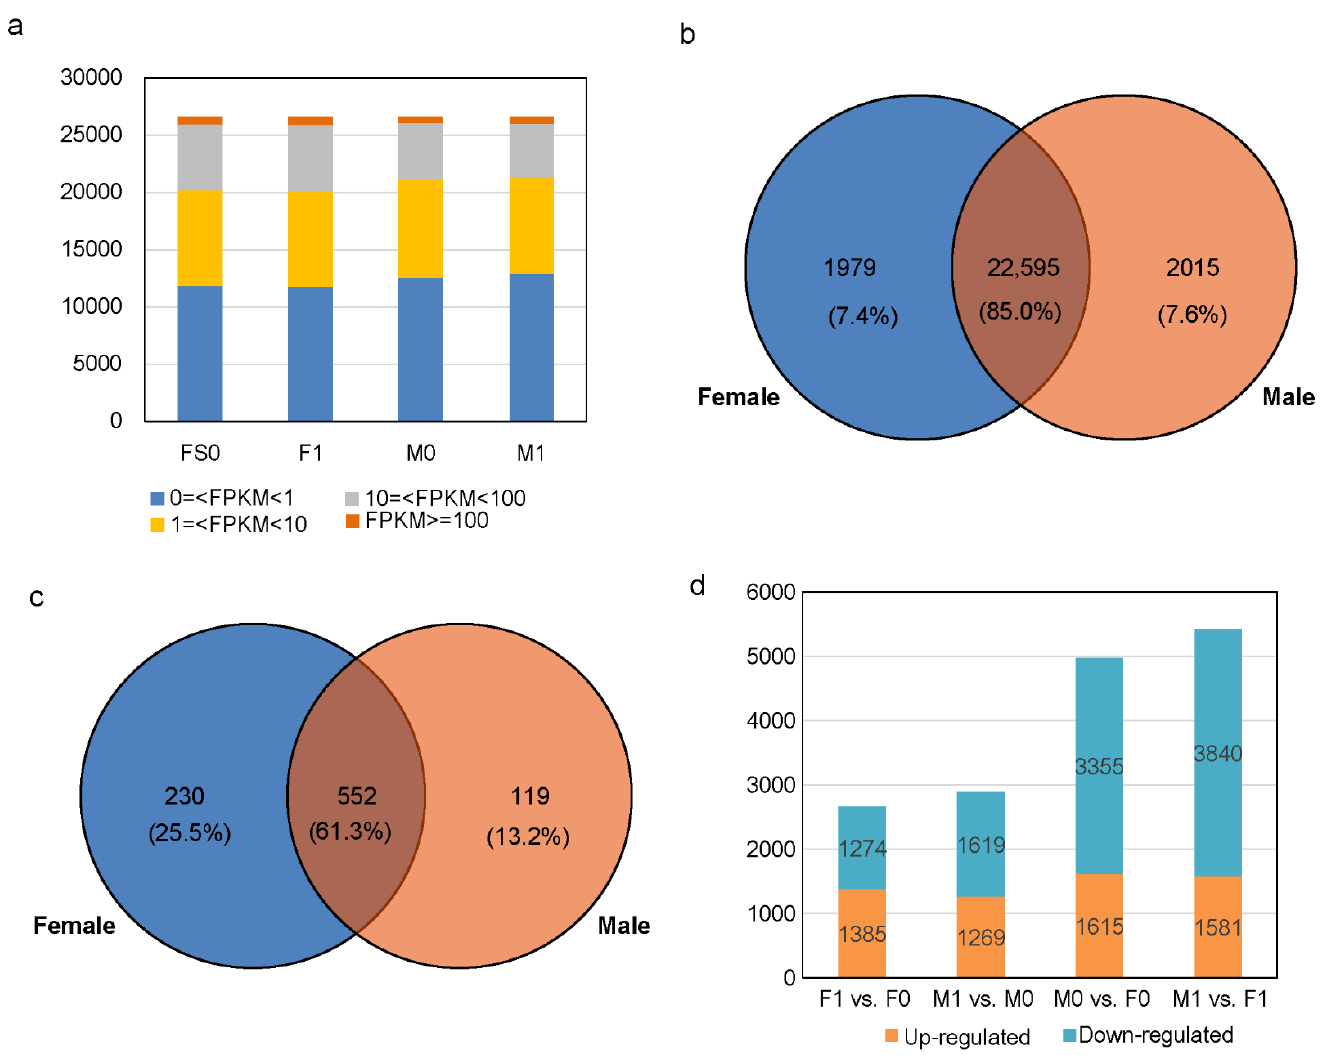
Figure 2. Overview of red bayberry M0, M1, F0 and F1 floral bud transcriptome. ( a ) Distribution of genes with high expression (FPKM ≥ 100), mid-level expression (100 > FPKM ≥ 10), low expression (10 > FPKM ≥ 1) and no expression (1 > FPKM ≥ 0). Venn diagram of genes expressed in female and male libraries ( b ) and genes with high expression in at least one library ( c ). ( d ) Distribution of up- and down-regulated DEGs in the pair-wise F1 vs. F0, M1 vs. M0, M0 vs. F0 and M1 vs. F1 anal-